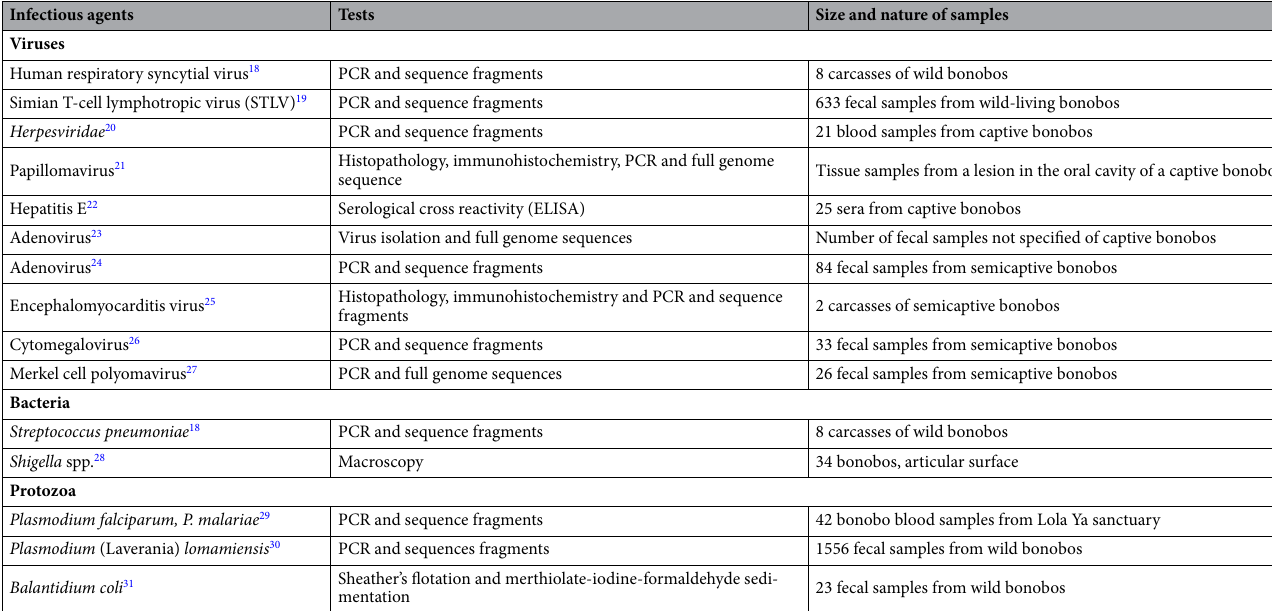
Table 1. Summary of previous studies conducted on bonobo ( Pan paniscus ) according to the size and nature of the samples